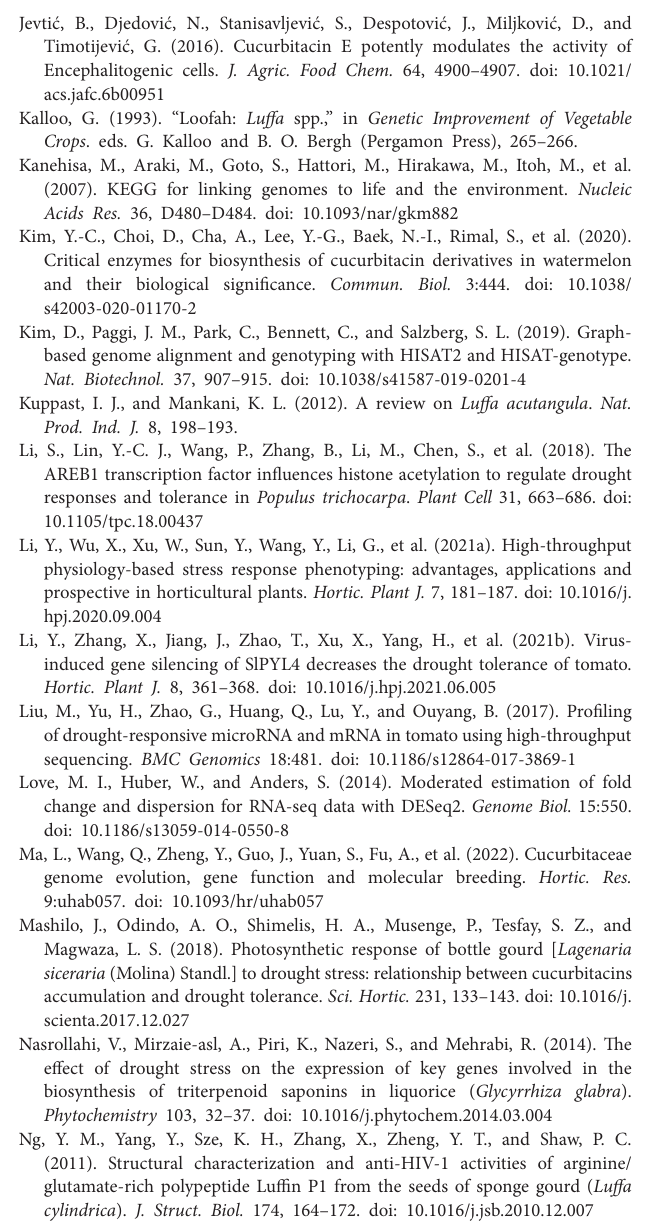
Supplementary Figure S1 | OPLS-DA analysis of detected metabolites. (A) Scores OPLA-DA plot. (B) R2X, R2Y, and Q2 plot. Supplementary Figure S2 | KEGG enriched pathways from the up-regulated metabolites in S1174. Supplementary Figure S3 | The correlation coefficients (A) and PCA (B) of DEGs. Supplementary Figure S4 | The number of DEGs belonging to different transcription factor families detected in S1174 and WM709. Supplementary Figure S5 | Expression profiles of LacCAS. (A) LacCAS read counts. (B) Relative expression of LacCAS after drought stress and ABA